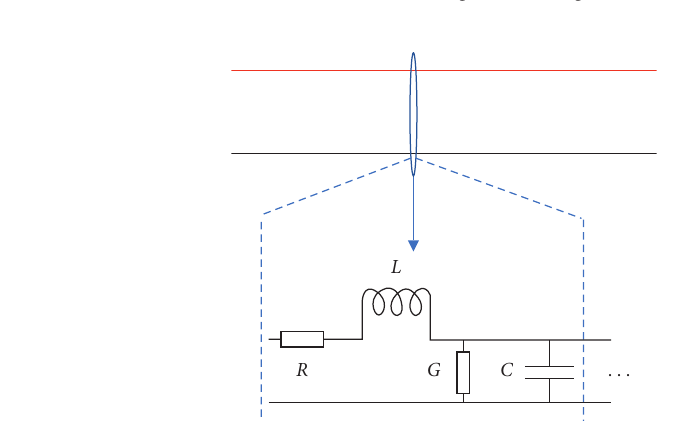
Figure 1: Schematic diagram of design ideas.